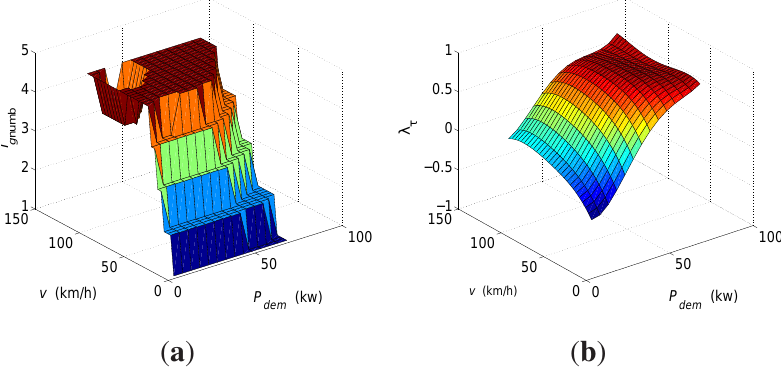
Figure 6. Decision maps, ζ = 0 . 82 . ( a ) Gear number map; ( b ) torque split ratio